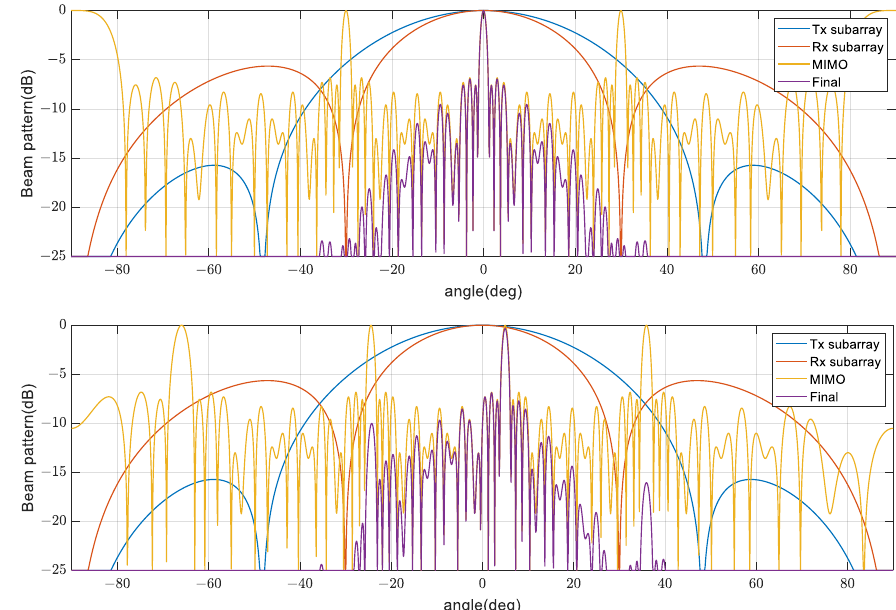
Figure 15. Non-redundant MIMO configuration. The ratios of the spacing among subarrays are